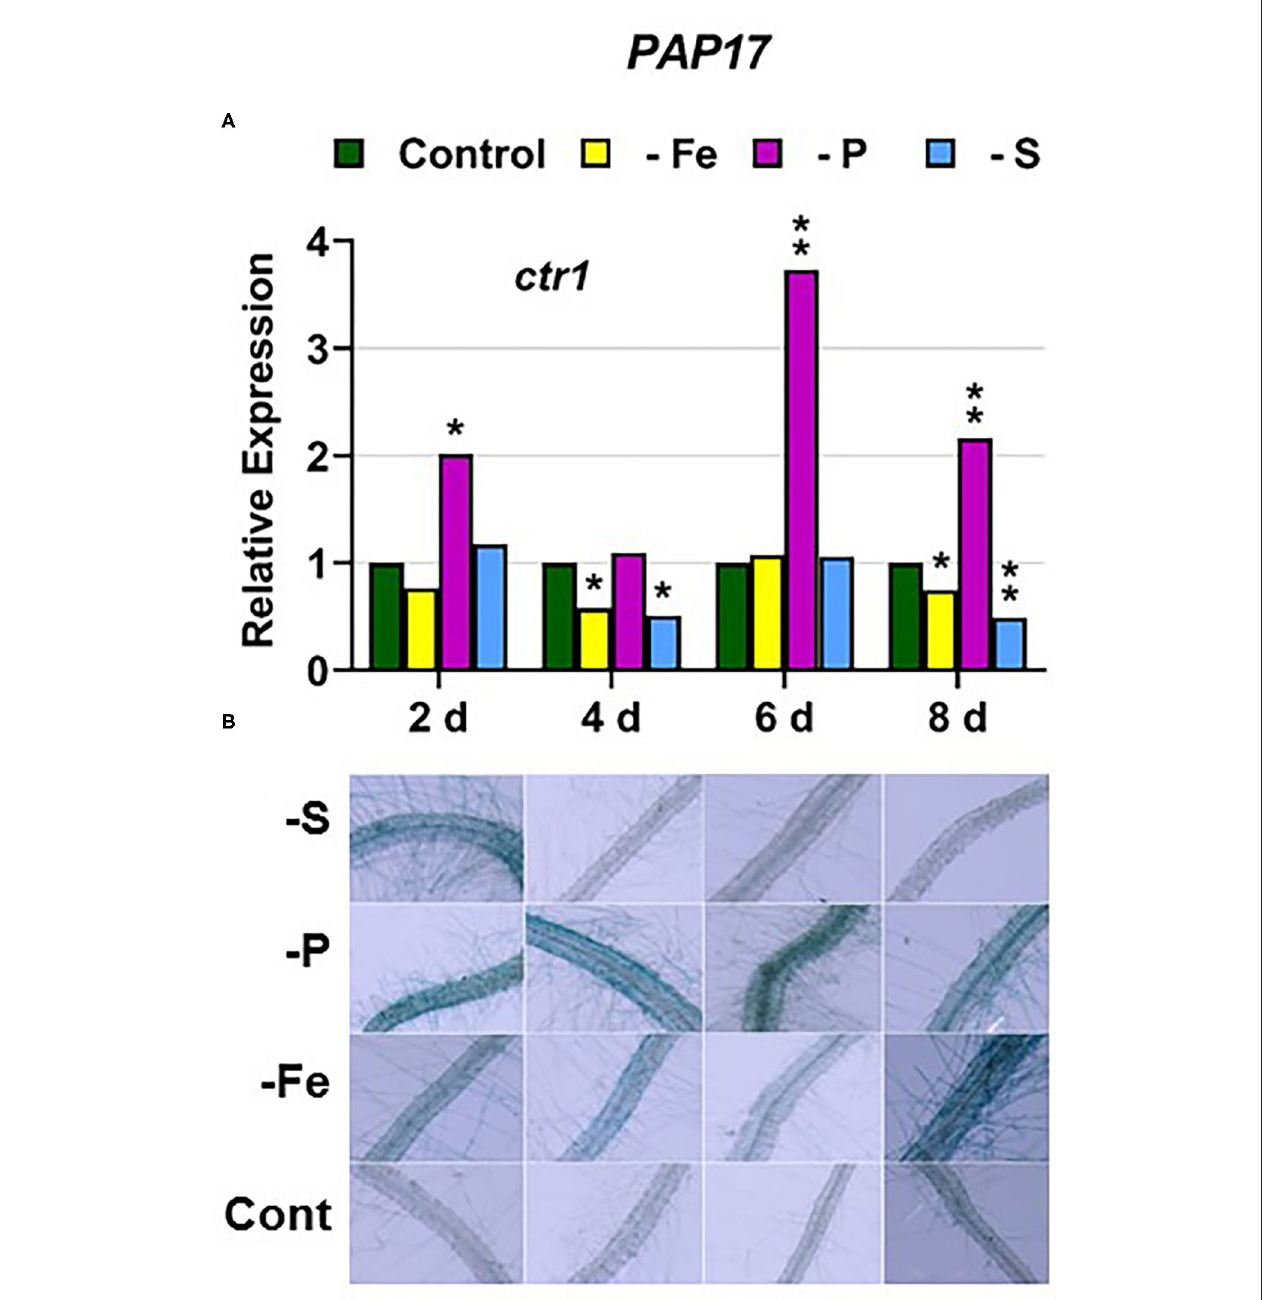
FIGURE 6 | Effect of Fe, P or S deficiency on the expression of the P-related gene PAP17 (A) ; and of phosphatase activity (PA; B ) in roots of the Arabidopsis ethylene mutant ctr1 . Treatments and determinations as in Figure 5 . Within each day and genotype, * or ** indicate significant differences ( P < 0.05 or P < 0.01) in relation to the control